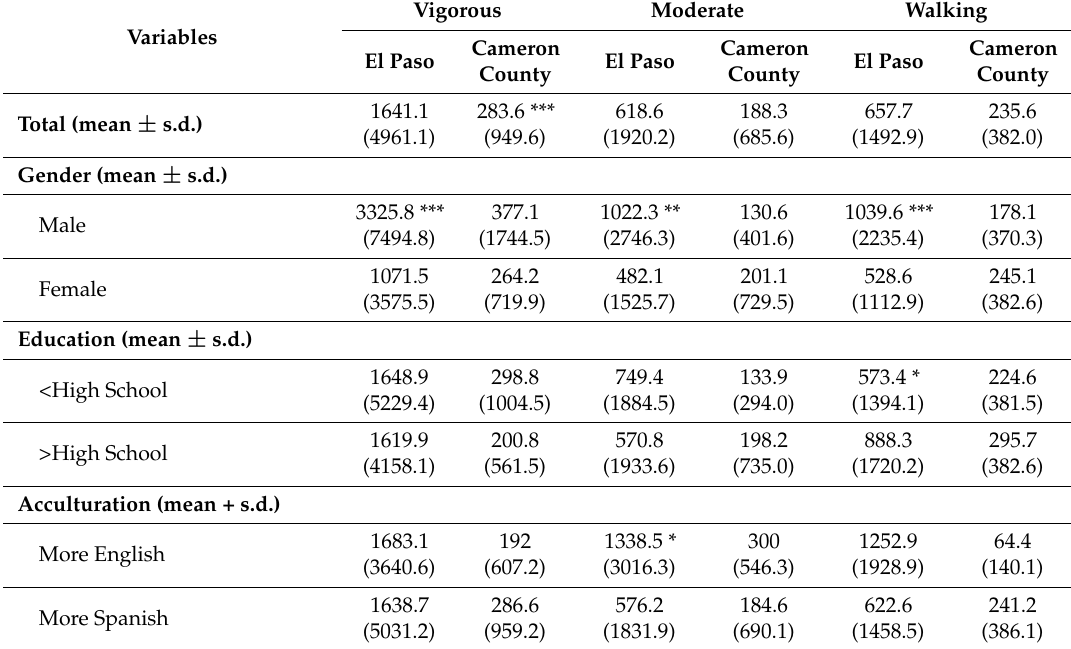
Table 2. The unadjusted association between demographic variables and the International Physical Activity Questionnaire (IPAQ) outcomes (met/min per